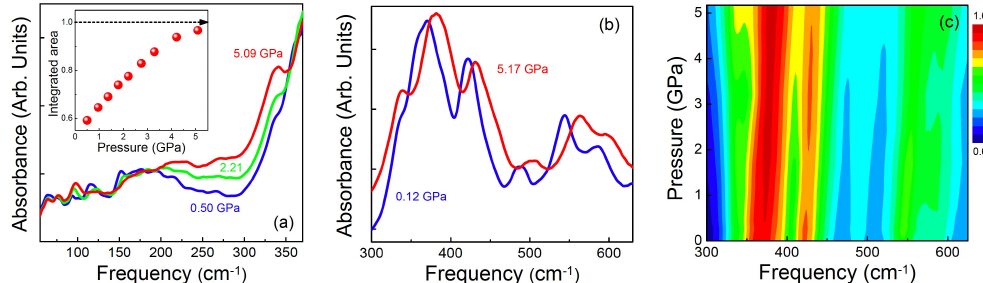
Figure 2. ( a ) Synchrotron-based far infrared spectrum of Na 9 [Ho(W 5 O 18 ) 2 ] · 35H 2 O as a function of pressure in the 55–375 cm − 1 region. Both intramolecular and intermolecular features are observed. Inset: Integrated area under the curve in the 220–310 cm − 1 frequency window. The latter corresponds to the transparency window and was therefore used as the integration range. ( b ) Close-up view of the far infrared response of Na 9 [Ho(W 5 O 18 ) 2 ] · 35H 2 O between 300 and 625 cm − 1 . ( c ) The same data as in panel ( b ) shown as a contour plot. Spectra at 12 different pressures were used to create the contour